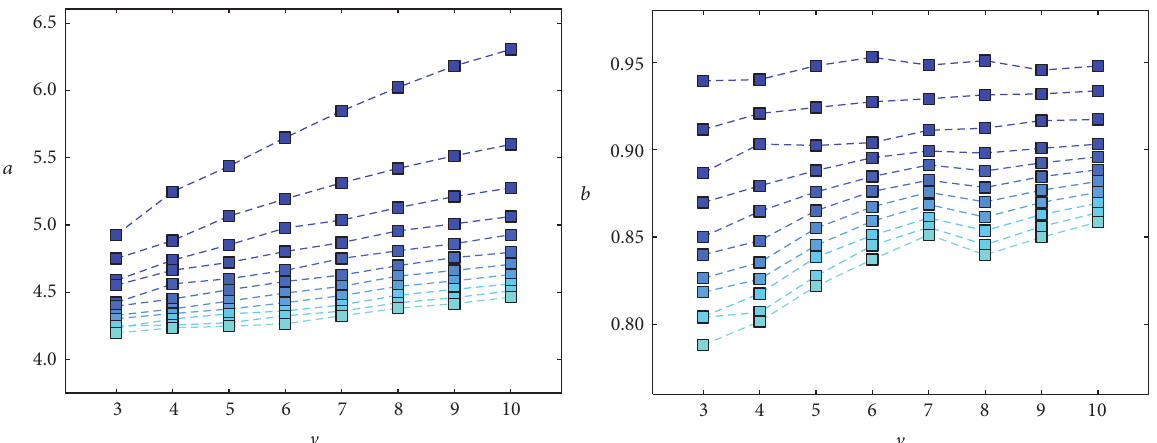
= 1.0 × 10 −7 , with 𝛽 varying in the range 0 ÷ 2 in T